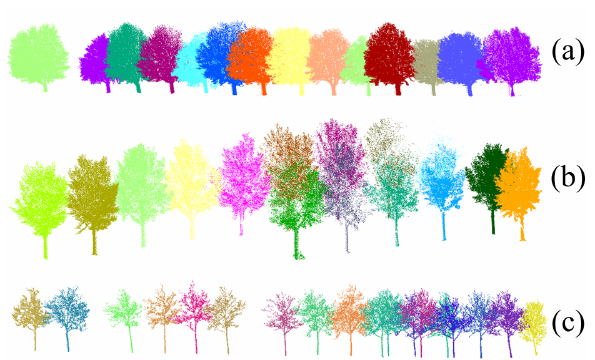
Figure 7: Individual tree delineation results of the studied 47 trees.